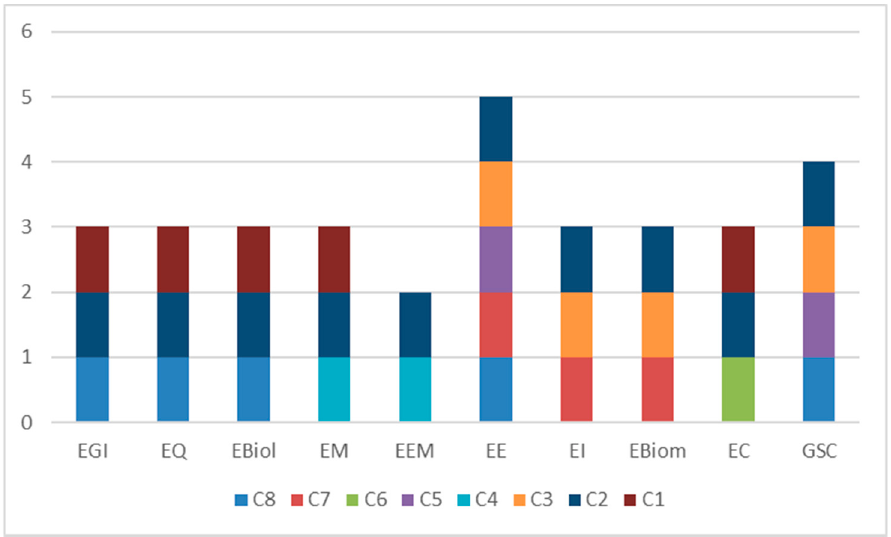
Figure 4. KOM competences distribution.